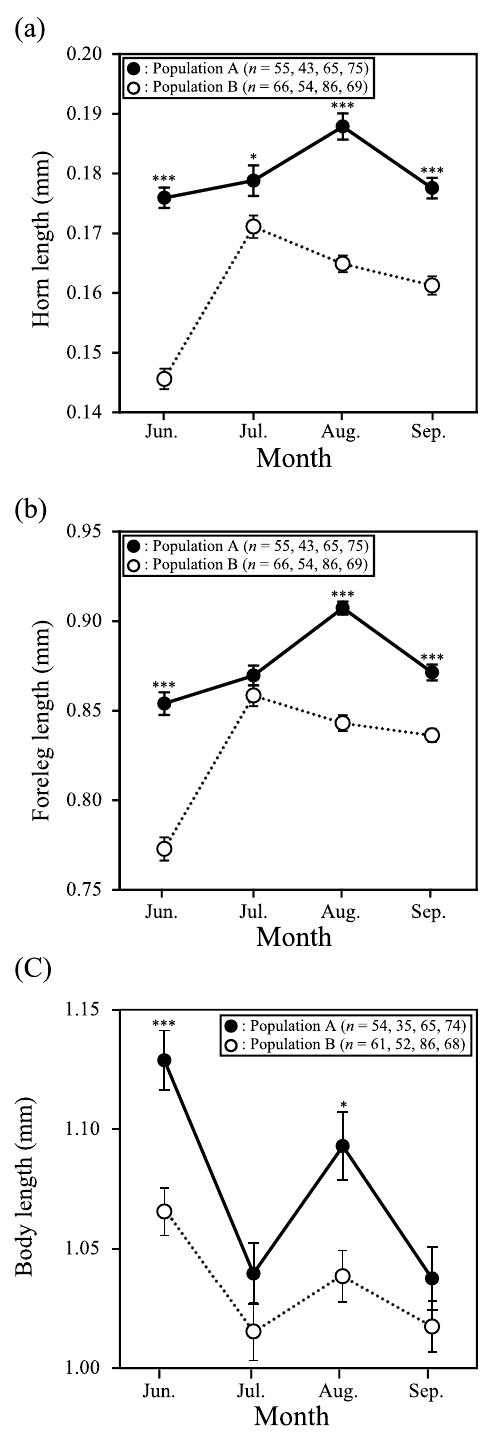
Figure 3. Temporal and between-population variation in the weapon size of soldiers. The average ( a ) horn, ( b ) foreleg, and ( c ) body length of soldiers in populations A and B from June to September are shown. Error bars denote s.e. Asterisks indicate significant differences between populations (* P < 0.05; *** P <